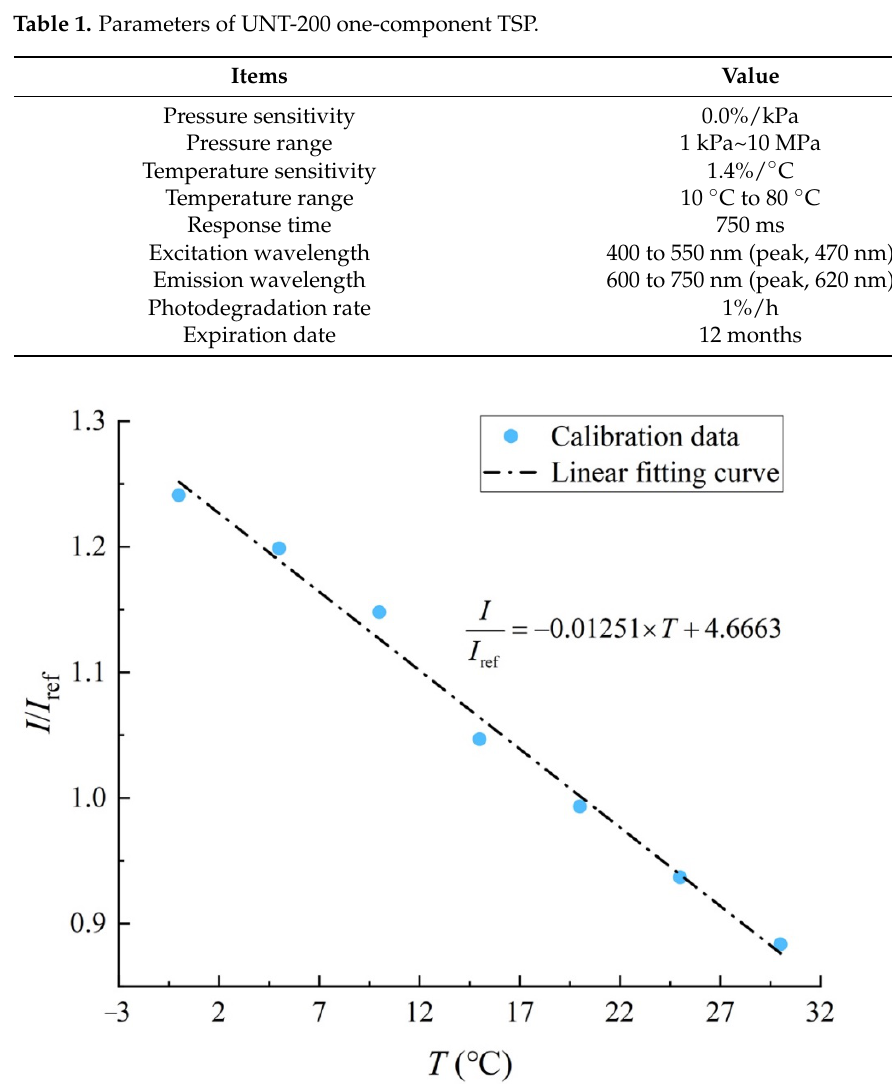
Figure 1. TSP calibration curve.